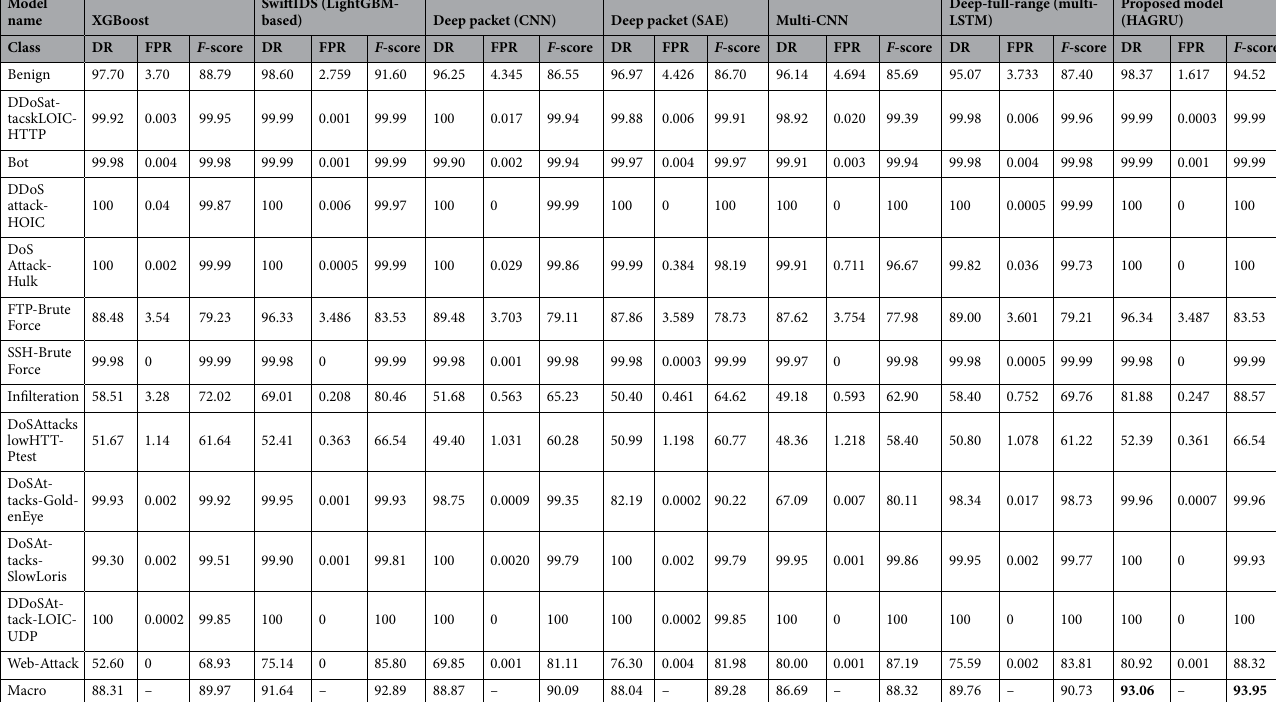
Table 6. Performance comparison of each model in CES-CIC-IDS2018 dataset (units: %, bold indicates the best